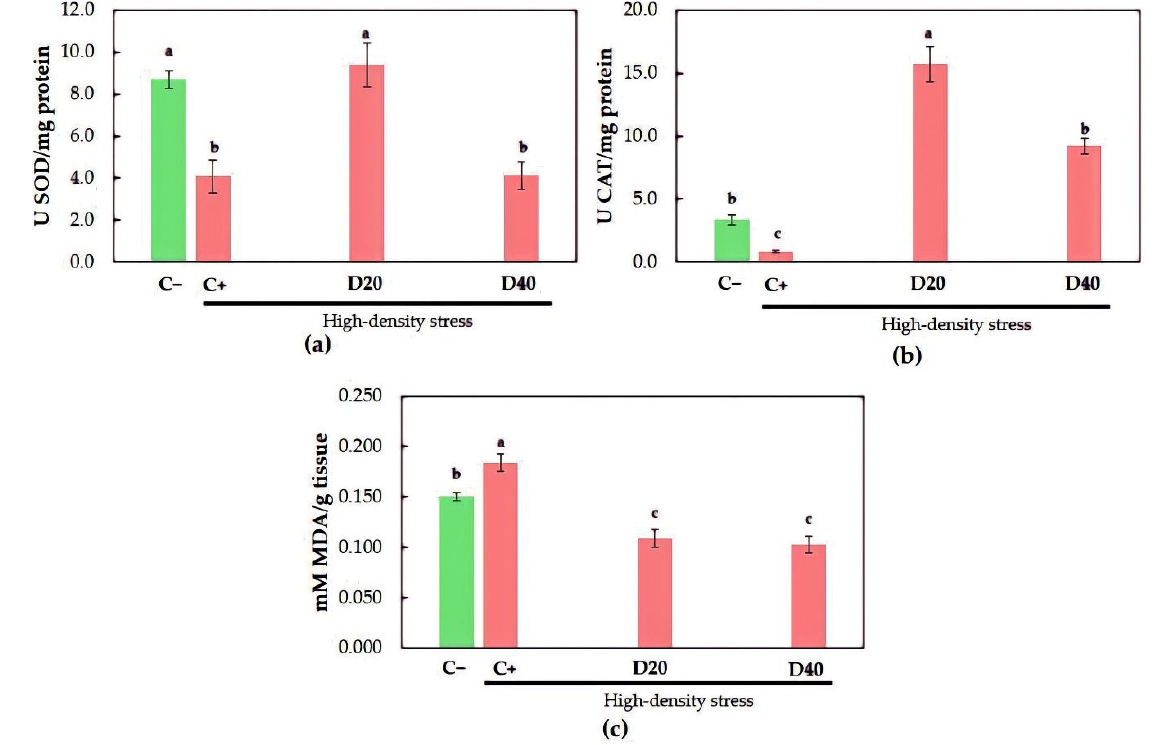
Figure 3. The effect of dietary agavin on ( a ) SOD activity, ( b ) CAT activity, and ( c ) MDA levels in Nile tilapia ( O. niloticus ) after 20 days under high rearing density (63 kg/m 3 ). C − , control without high-density stress; C+, control under high-density stress; D20, experimental diet supplemented with 20 g/kg agavin under high-density stress; D40, experimental diet supplemented with 40 g/kg agavin under high-density stress. Data obtained from five biological replicates are shown as the mean ± SE values. Different letters correspond to significant differences ( p < 0.05) according to Tukey’s HSD test.